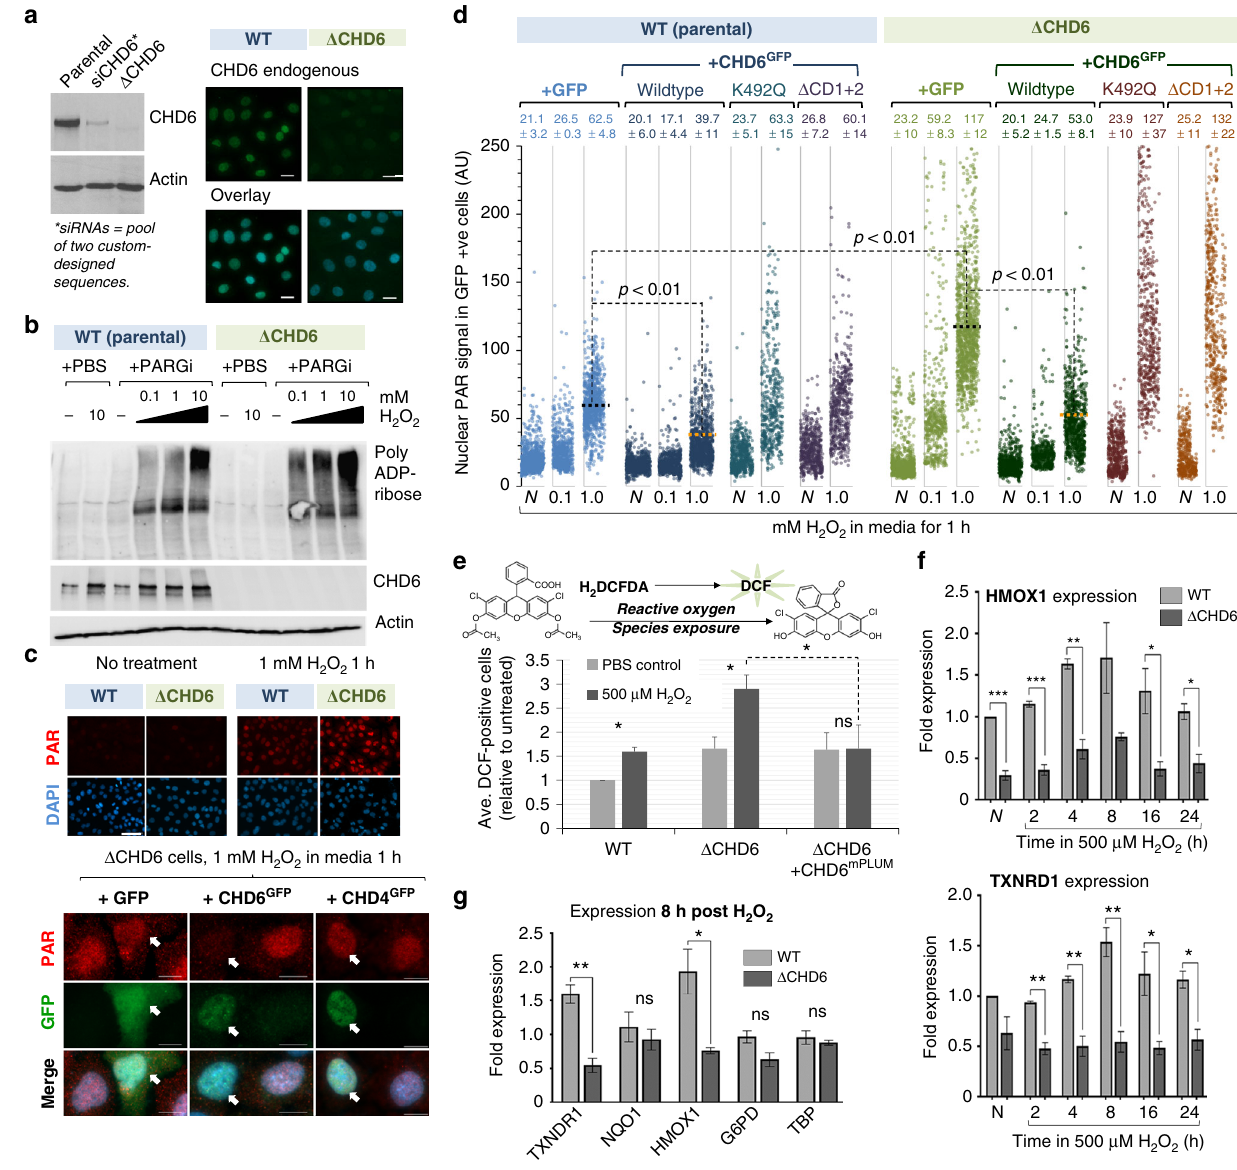
Fig. 4 Cells lacking CHD6 display elevated PAR, oxidative stress and have diminished antioxidant responses. a A549 were subjected to CRISPR-mediated CHD6 gene ablation ( Δ CHD6) or treated with CHD6 siRNA (siCHD6) before being immunoblotted (left) or immunostained (right) as indicated. Parental refers to the wild-type (WT) A549 used to derive Δ CHD6. Scale bars = 20 µ m. b WT and A549 Δ CHD6 were treated ±5 µ M PARGi and indicated H 2 O 2 doses for 1 h before immunoblotting for PAR, CHD6 and actin. Representative blot shown, n = 3. c WT and Δ CHD6 A549 were complemented with GFP, CHD6 GFP or CHD4 GFP and treated with 5 µ M PARGi ± 1 mM H 2 O 2 in media for 1 h before immunostaining for PAR (red) and DAPI (blue). Lower panels highlight GFP-expressing cells. Scale bars = 10 µ m. d WT and A549 Δ CHD6 were transfected with GFP, or GFP-tagged CHD6 wildtype , CHD6 Δ chromo or CHD6 K492Q before treatment with 5 µ M PARGi ± 0 – 1 mM H 2 O 2 for 1 h and immunostaining for PAR and GFP as in ( c ). Nuclear PAR in >1000 GFP-positive cells ( n = 3) was quanti fi ed using ImageJ. Dot colors represent: light blue = GFP alone, WT cells; dark blue = WT CHD6 GFP , WT cells; cyan = K492Q CHD6 GFP , WT cells; purple = Δ CD1 + 2 CHD6 GFP , WT cells; light green = GFP alone, Δ CHD6 cells; dark green = WT CHD6 GFP , Δ CHD6 cells; dark red = K492Q CHD6 GFP , Δ CHD6 cells; orange = Δ CD1 + 2 CHD6 GFP , Δ CHD6 cells. Error bars = s.e.m.; n = 3. e WT, A549 Δ CHD6 and A549 Δ CHD6 complimented with CHD6 mPLUM , incubated with H 2 DCFA then exposed ± 0.5 mM H 2 O 2 for 1 h and FACS analysis of green fl uorescent DCF signal. Data represent an average of the percent DCF-positive cells within a population, expressed relative to the PBS-treated wild-type control. Error bars = s.e.m.; n > 3. f , g WT and A549 Δ CHD6 were exposed to ±500 µ M H 2 O 2 in media for up to 1 day and analyzed by qPCR to ascertain HMOX1, TXNRD1, NQO1, G6PD and TBP mRNA expression. Error bars = s.e.m.; n = 3. In all cases, P values are for Student ’ s t -test: ns not signi fi cant ( P > 0.05); * P < 0.05; ** P < 0.01; *** P < 0.001. In all cases, ± refers to with and